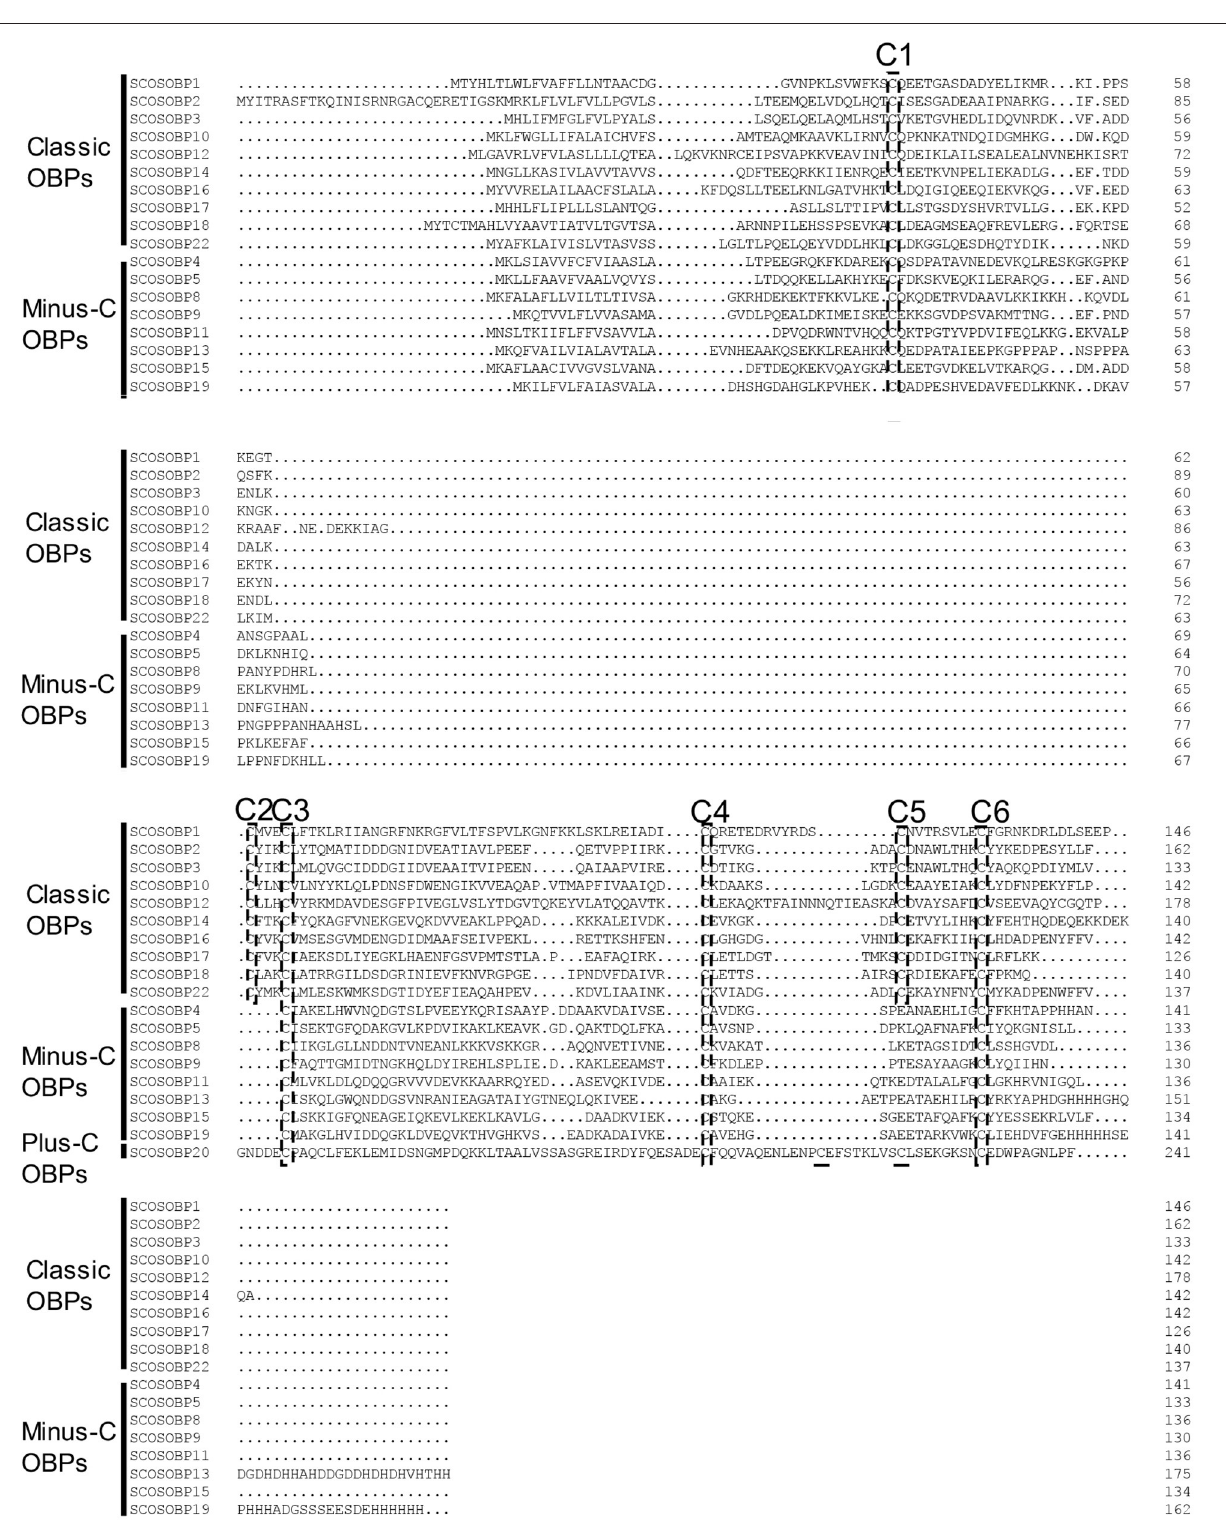
Frontiers in Physiology | www.frontiersin.org